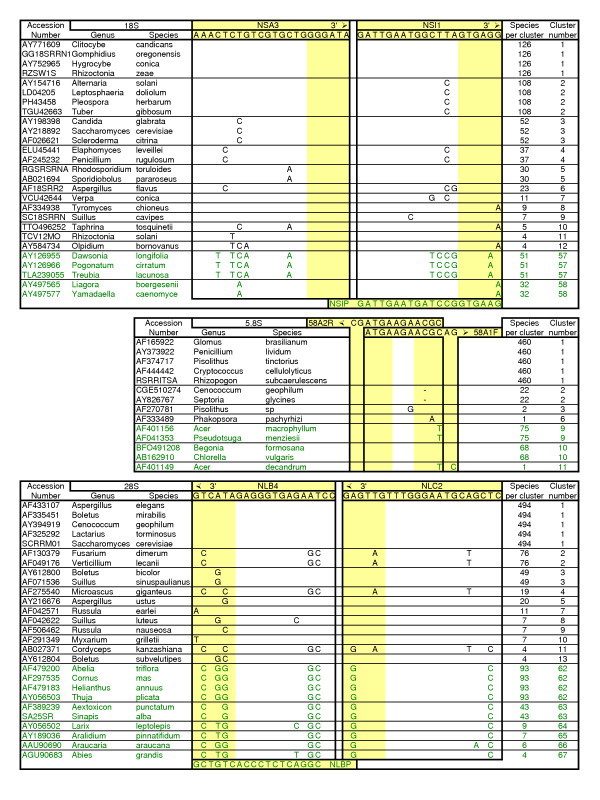
Multiple alignments of published sequences for the primer sites. Primer sequence alignments are depicted with consensus bases blank and mismatch bases noted. The six bases at the 3' end of the primers are highlighted yellow. "Clusters" were created by sorting the sequences in Excel and grouping identical sequences. "Species per cluster" numbers indicate the number of species with that mismatch pattern. Only one sequence per species was included in the alignment (final totals of: 584 species for 18S, 633 species for 5.8S, and 943 species for 28S). The "Cluster number" is a sequential numbering of clusters in order of descending "Species per cluster" with sequences from the EMBL Fungal database numbered before sequences from the EMBL Plant database (the latter are presented in green font). Sequences were collected using FASTA [40] for a set of 12 taxonomically representative fungal sequences for each region. Most mismatch groups containing fewer than 4 species were removed from the figure to save space. The full alignment is also available [see Additional file 1].